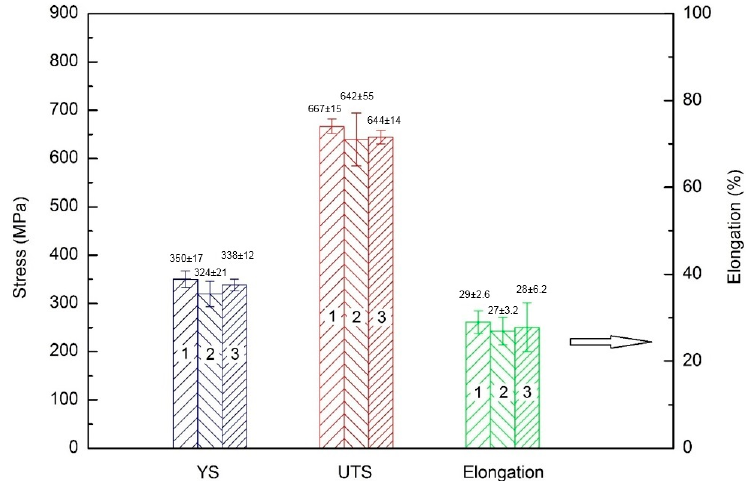
Figure 8. Effects of heat input on mechanical properties of as-deposited WM. Each data point represents the average of more than 10 specimens from one of three welding heat inputs.